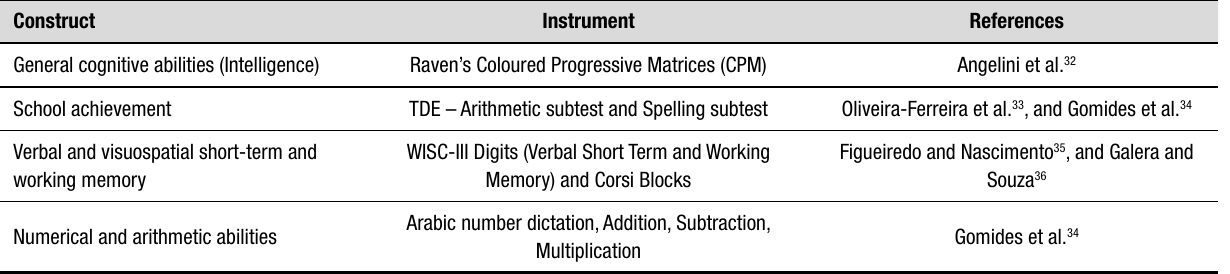
Table 2. Neuropsychological